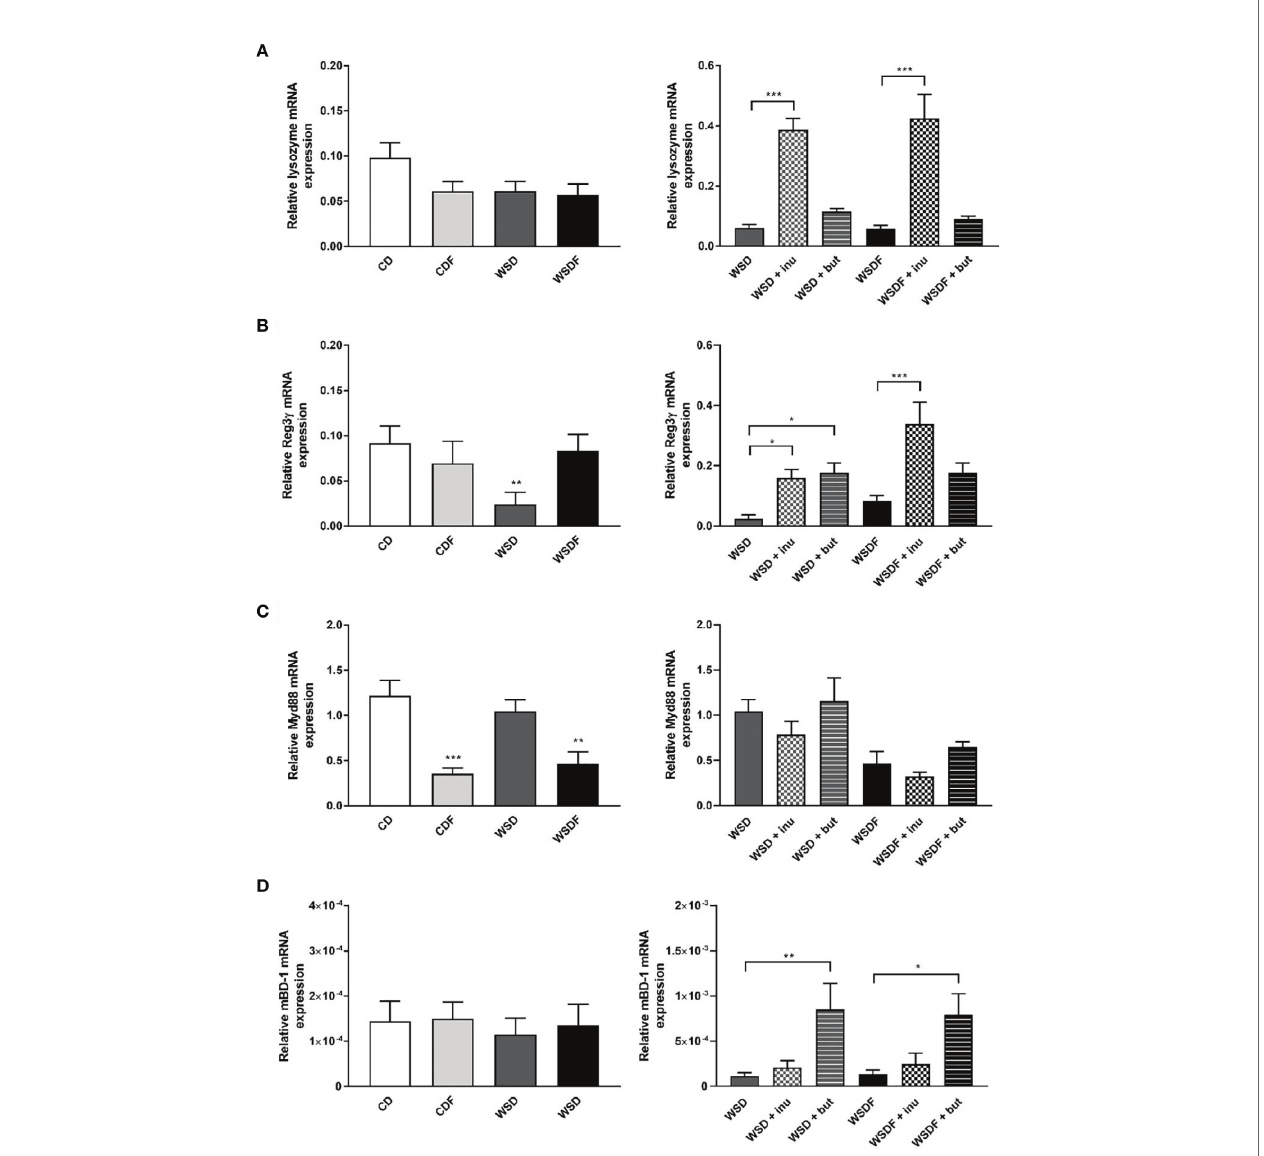
FIGURE 4 | Effects of inulin and sodium butyrate on antimicrobial peptide expression. C57BL/6 mice fed different diets as described in Figure 1 are shown. Relative mRNA expression level of lysozyme (A), Reg3 g (B) , MyD88 (C) in the ileum and mBD-1 (D) in the colon determined by quantitative RT-PCR. Data are presented as means +/- standard error of the mean (SEM) (n= 6 – 8). Statistical analysis was performed by one-way ANOVA with Dunnett´s or Sidak´s post-test or by Kruskal- Wallis-test for non-parametric data with a Dunn ’ s post-test. Signi fi cant differences are indicated as *p-value < 0.05; **p-value < 0.01; ***p-value <